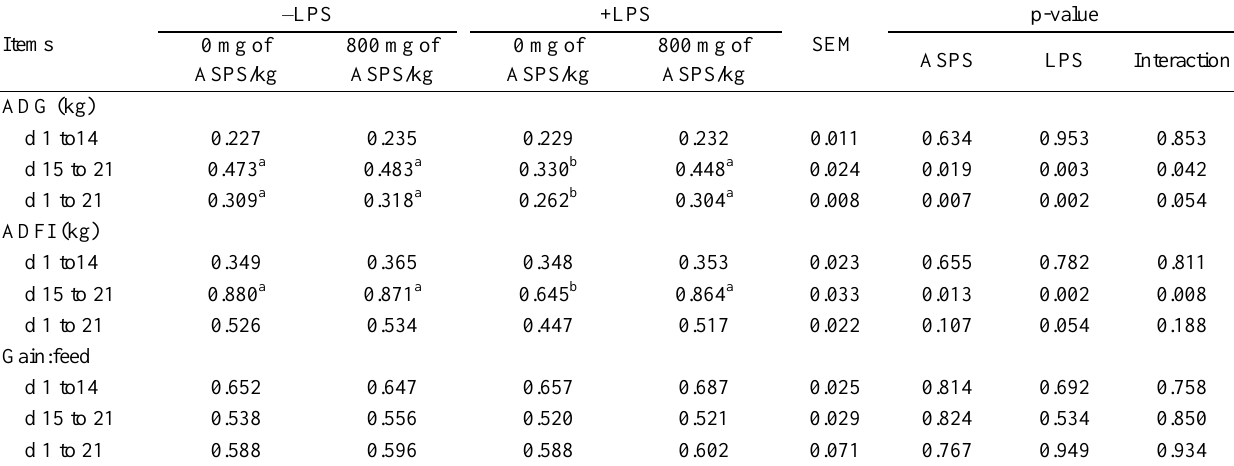
Table 2. Effect of dietary ASPS supplementation on performance of weaned piglets challenged with LPS 1